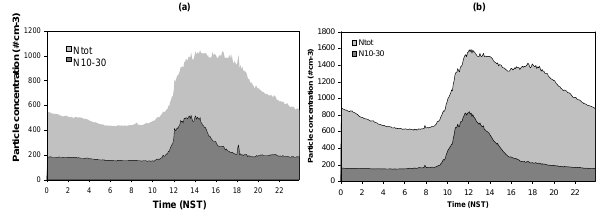
Fig. 2. Mean diurnal variation of the aerosol total number concen- tration Ntot (light grey area), and 10-to-30nm integrated number concentrations N10–30 (dark grey) averaged over the whole mea- surement period for the (a) dry season, (b) pre-monsoon season, (c) monsoon season and (d) post-monsoon season.